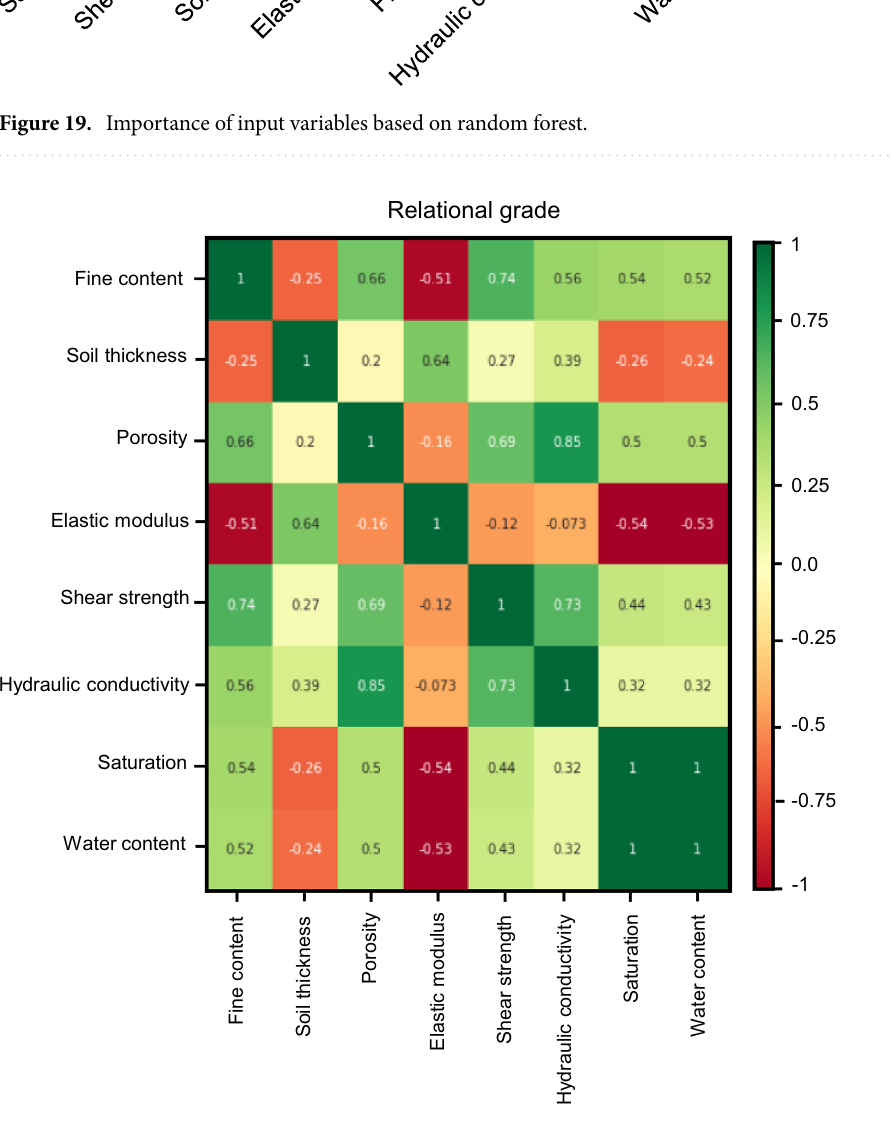
Figure 20. Gray relational grade (GRG) results based on random